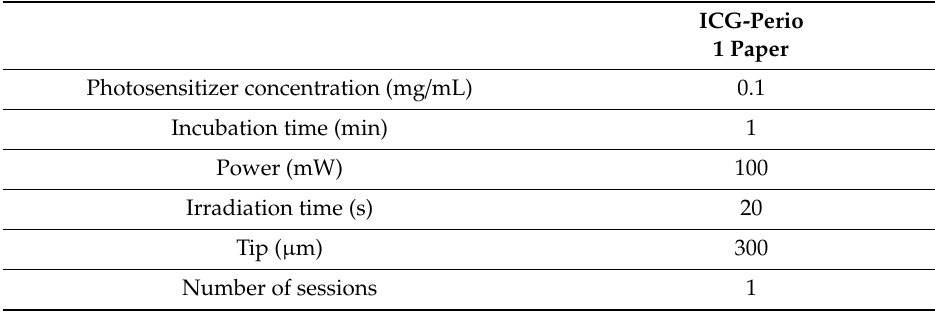
Table 11. Single study with indocyanine green (ICG).